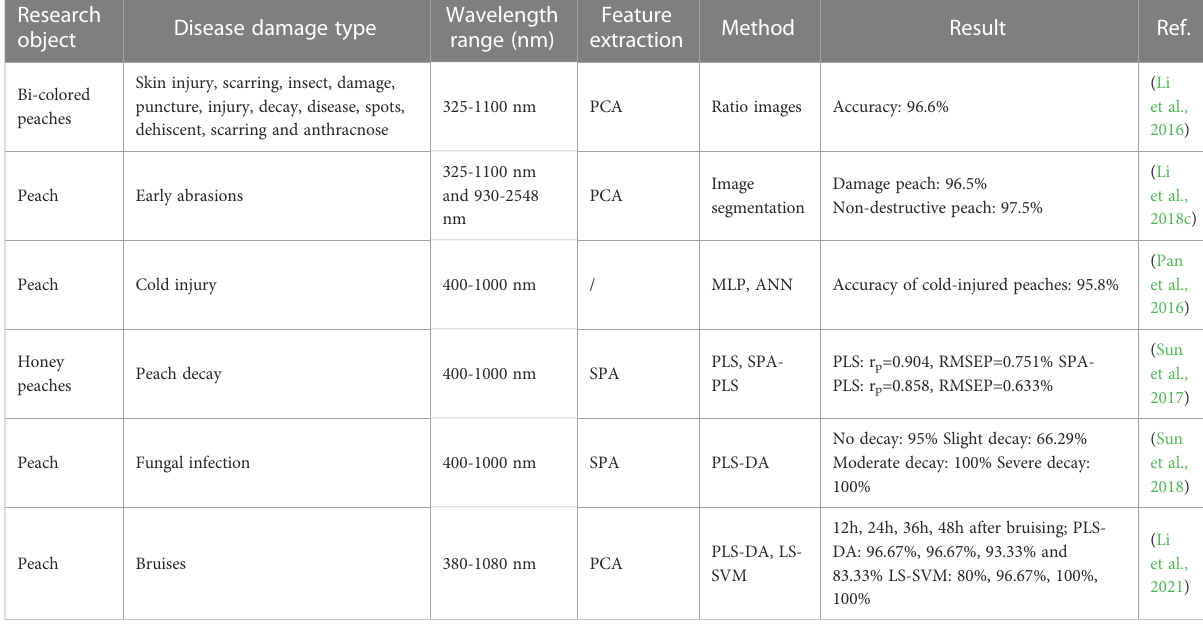
TABLE 6 Summary for the detection of fruit disease and damage based on phenotypic information using hyperspectral imaging.